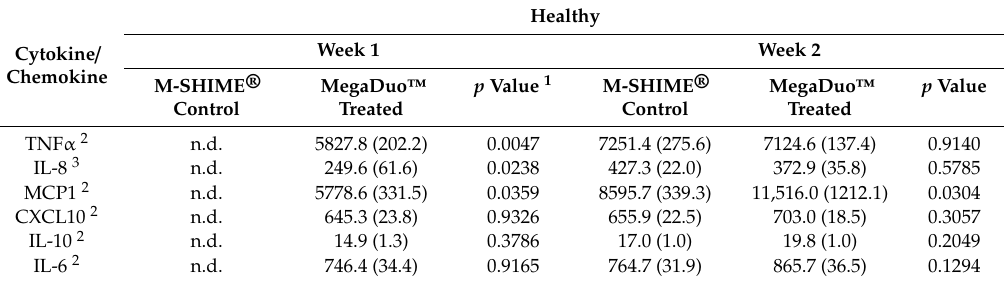
Table 2. E ff ect of M-SHIME ® supernatants on cytokine and chemokine release in the co-culture system under healthy conditions.